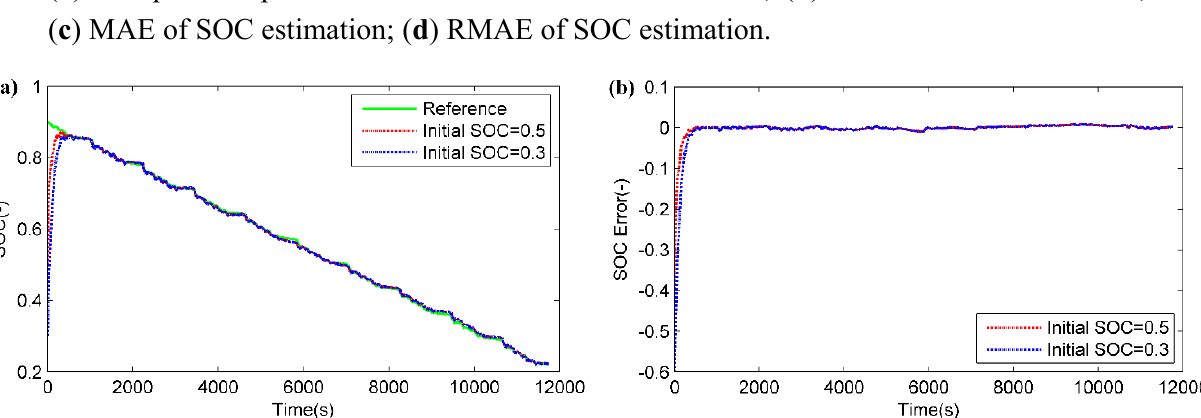
Figure 10. Estimation results with inaccurate initial SOCs for LCO cell: ( a ) Comparative profiles of reference and estimated SOC; ( b ) Error of SOC